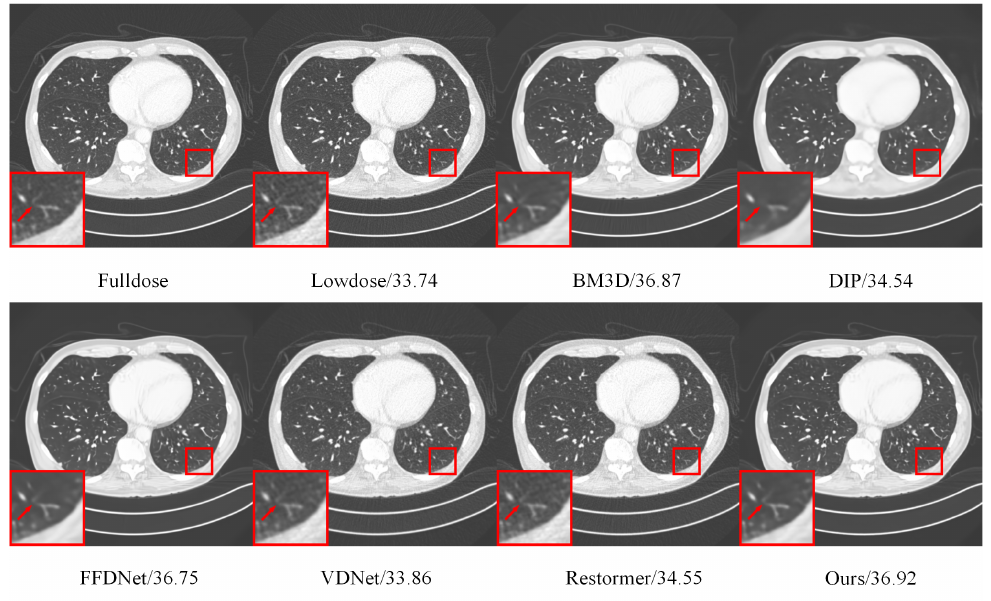
Figure 12. Visual comparison of the denoised images for the low-dose X-ray image. The quantitative PSNR results are listed behind the noisy and denoised